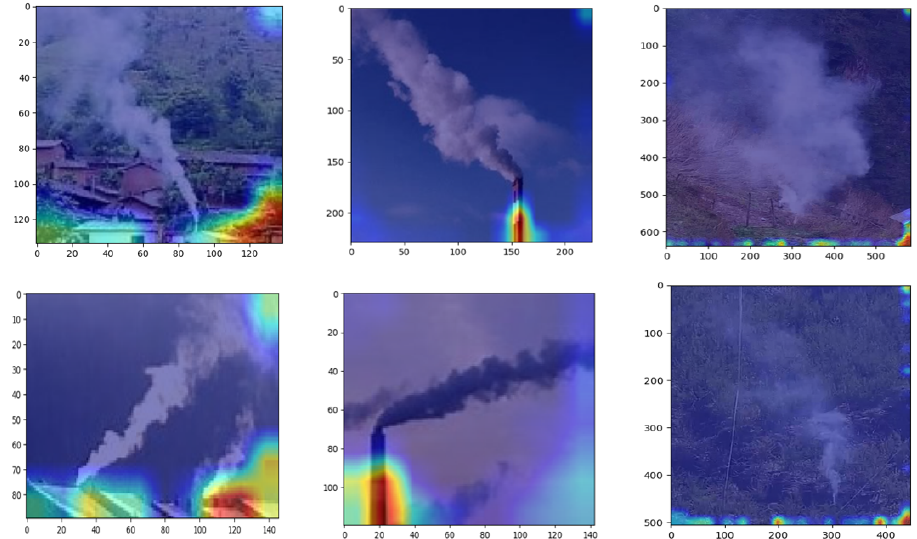
Figure 10. Attentional salient feature map of some test samples.